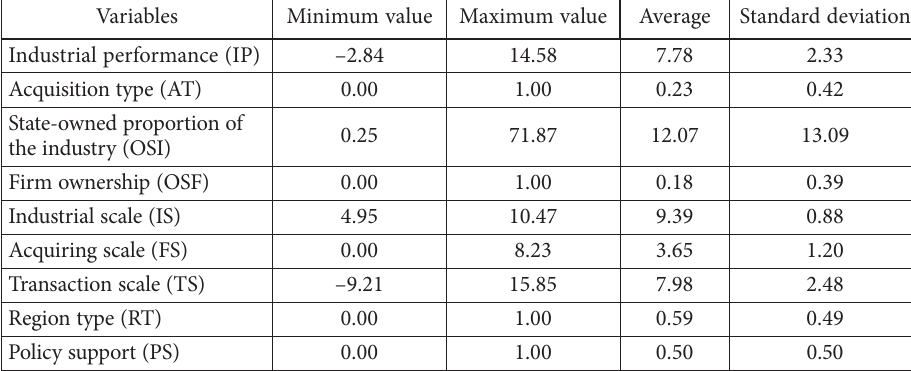
Table 2. Descriptive statistics of variables